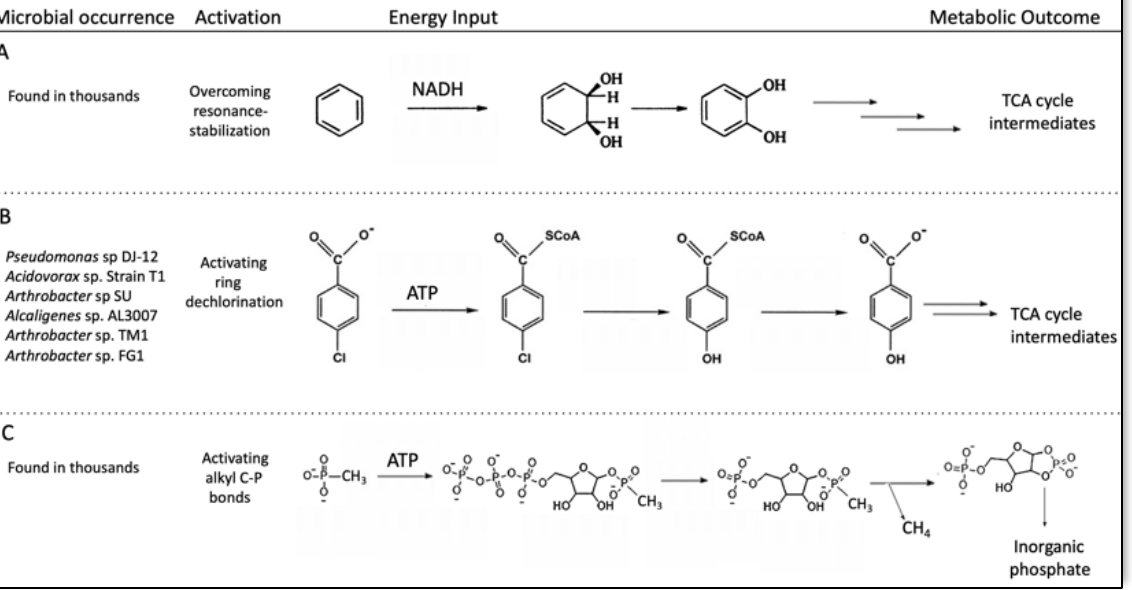
Figure 3. Examples of metabolic activation in microbial degradation pathways. ( A ) A major aerobic bacterial pathway for metabolizing benzenoid rings requires energy input to activate molecular oxygen for attack on the ring. The activated ring is then cleaved and fragments are assimilated in subsequent metabolism. ( B ) 4-Chlorobenzoate is activated for dichlorination via an initial energy- requiring thioesterification of the carboxylate moiety via coenzyme A. ( C ) The C – P bond of alkylphosphonates is relatively unreactive and is activated using ATP to accomplish C – P bond cleavage to release inorganic phosphate in phosphorus-poor environments.